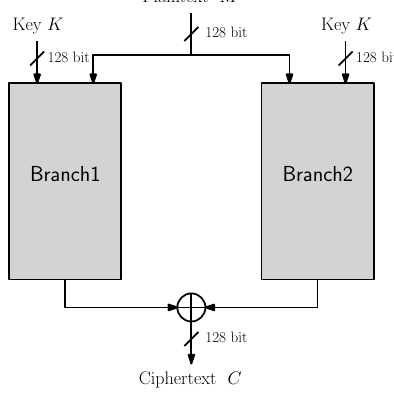
Figure 1: Overview of Orthros